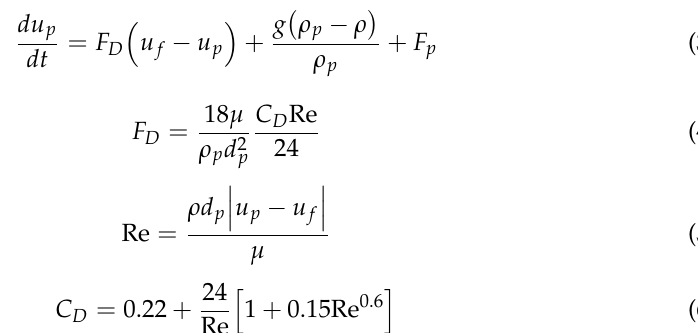
( b ) ( c ) Figure 1. Three blowing scheme models for large-aperture channel sealing. ( a ) The overall structure scheme model; ( b , c ) the structure and location of the outlet of the radial blowing scheme. 3. Numerical Simulation We used ANSYS software to simulate the motion of gas and dust particles under three different blowing schemes. A larger volume of cylindrical extension domain was added at the channel port to simulate the effect of the external environment on the large- aperture channel. The structure of the large-aperture channel is complex, and the calcula- tion of the flow field and the discrete phase in the channel should be considered. The coupling analysis of high-power laser and flow field will become the focus of future re- search. To ensure the efficiency and accuracy of the calculation, the finite volume method is used to discretize the computational domain space. At the same time, the SIMPLE algo- rithm is used to solve the governing equations of each volume element. During the nu- merical simulation, we assumed that the gas normal and tangential velocities are zero at the fluid-solid interface. Any change in the motion of the gas will not affect infinity. Fur- thermore, on both sides of the interface of different gases, the gases have equal normal